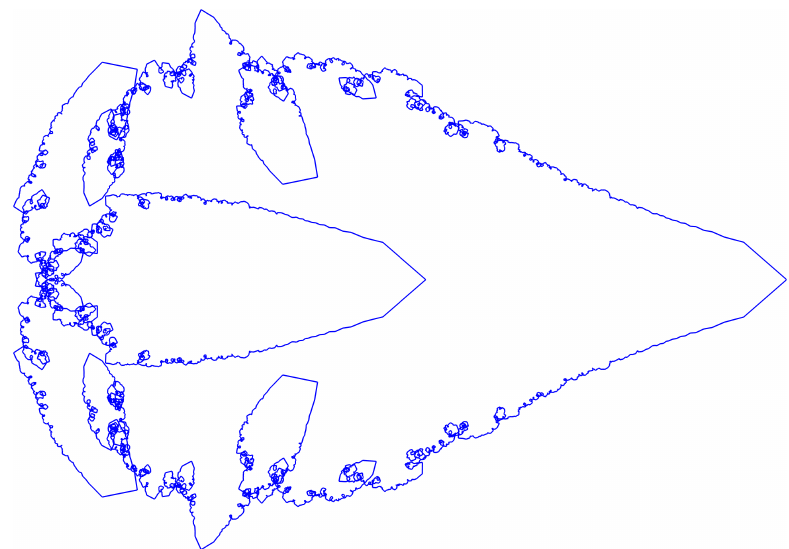
Figure 4. Polygonal prime fractal F p ( 10 4 )